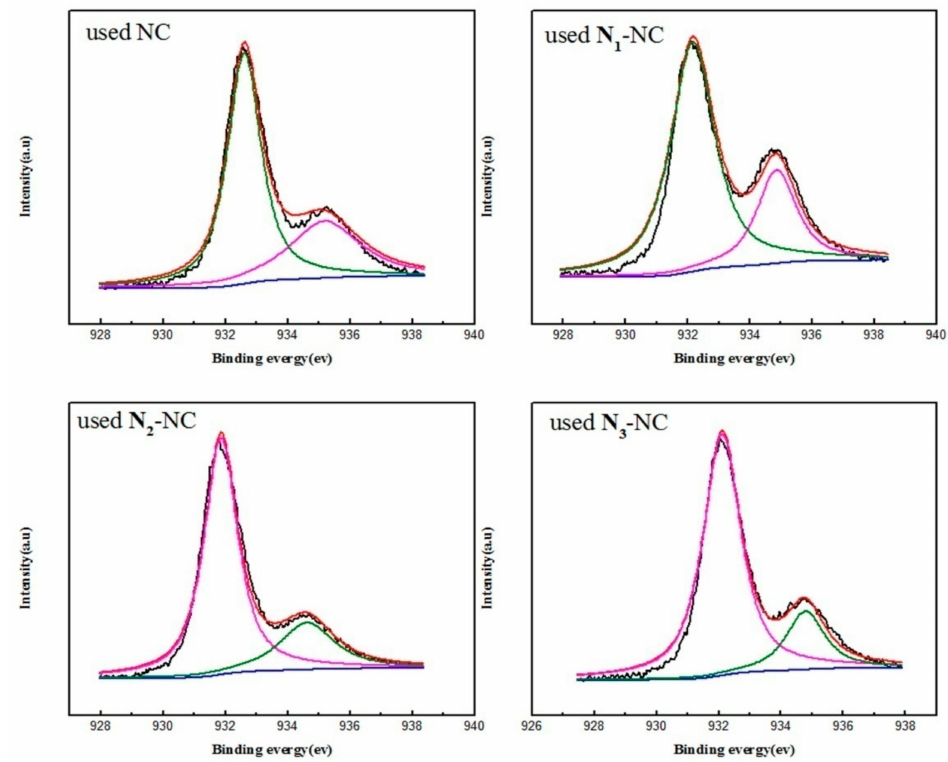
Figure 9. High-resolution XPS spectra of Cu 2p 3/2 of the fresh and used catalysts.